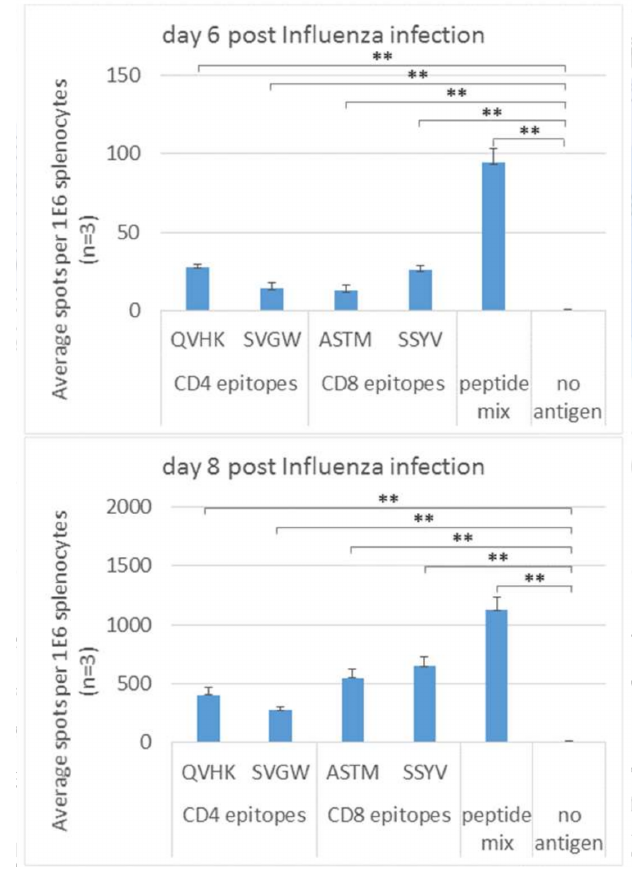
Figure 3. IFN γ ELISPOT response in the spleen following intranasal infection with Influenza strain A / Puerto Rico / 8 / 1934 H1N1. Mice were infected with 20 pfu and groups of 3 spleens were collected in the indicated time points. Splenocytes were stimulated in situ in an ELISPOT assay with MHC peptide epitopes (1 µ M total peptide concentration). Two immunodominant CD4 peptides epitopes (I-A b -restricted, NP311-325 QVYSLIRPNENPAHK, designated QVHK; NA161-175 SVAWSASACHDGMGW, designated SVGW), two CD8 peptide epitopes (D b -restricted, NP366-374 ASNENMETM, designated ASTM; PA224-233 SSLENFRAYV, designated SSYV) and a mixture of the four were used for stimulation. Data are representative of three independently performed experiments. ** p <